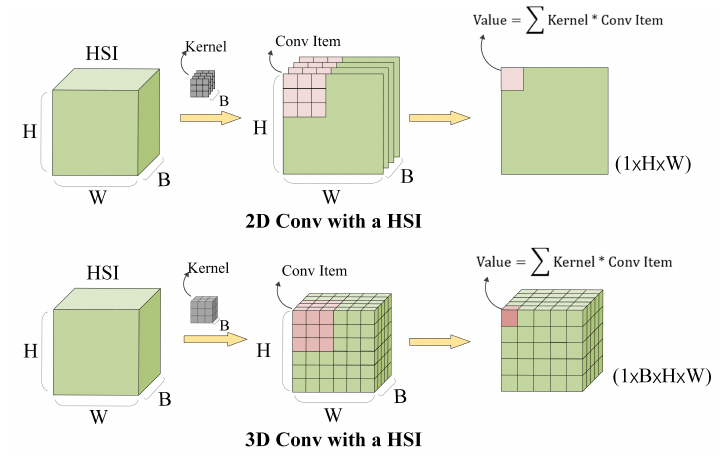
Figure 3. 2D and 3D Conv schematics. H, W, B represent image height, image width, and image band, respectively. In 2D Conv, the kernel number must manually adapt to the band number of the input HSI. 3D Conv can auto-adapt to bands of HSI and simultaneously extract spatial-domain and spectral-domain